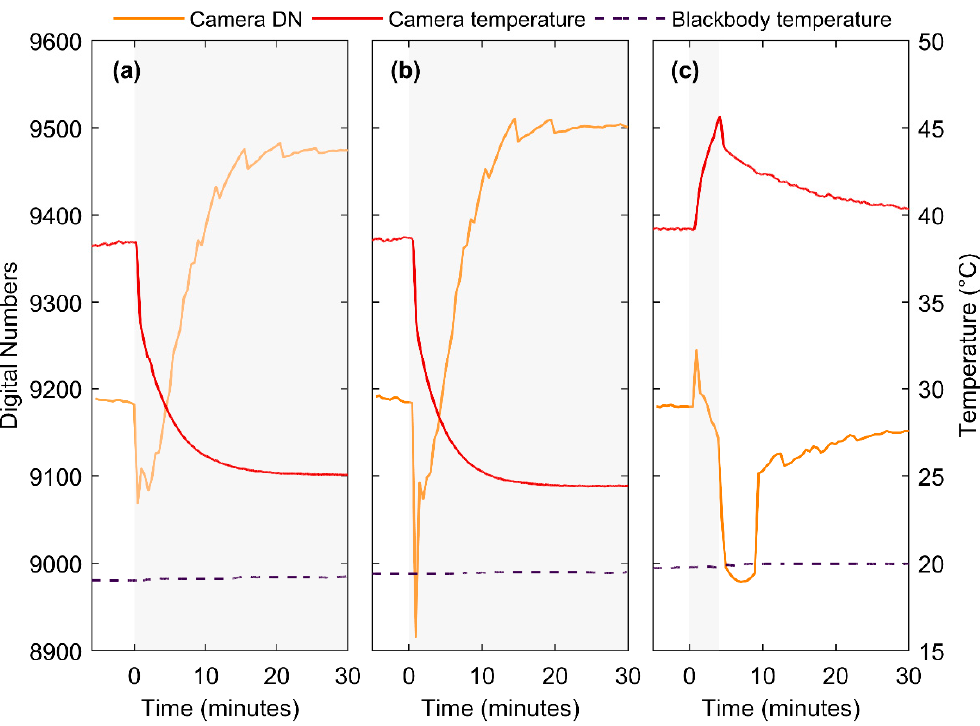
Figure 4. Simulation of the effect of wind and radiative heating on the camera while imaging a blackbody at a constant temperature, ( a ) with wind speed of 2 ms − 1 , ( b ) with wind speed of 3.3 ms − 1 and ( c ) with radiative heating from a 500 W lamp. Data are plotted using a 30 s moving average for clarity. The shaded area shows the treatment duration.